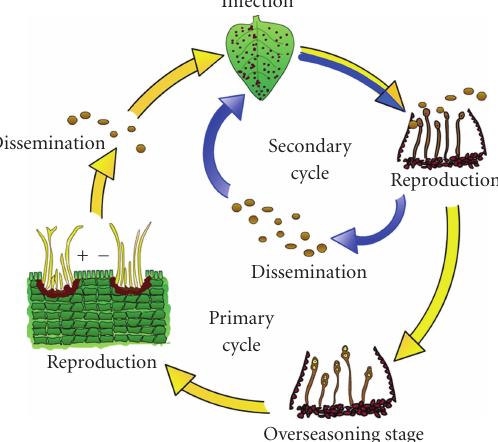
Figure 1: Diagram of monocyclic (yellow) and polycyclic (yellow and blue) fungi. In monocyclic diseases the fungus produces spores at the end of the season that serve as primary and only inoculum for the following year. The primary inoculum infects plants during the growth season and, at the end of the growth season, produces new spores in the infected tissues. These spores remain in the soil (overseasoning stage) and serve as the primary inoculum the following season. In polycyclic fungal pathogens, the primary inoculum often consists of the sexual (perfect) spore or, in fungi that lack the sexual stage, some other structures such as sclerotia, pseudosclerotia, or mycelium in infected tissue. This inoculum causes the primary infection and then large numbers of asexual spores (secondary inoculum) are produced at each infection site and these spores can themselves cause new (secondary) infections that produce more asexual spores for more